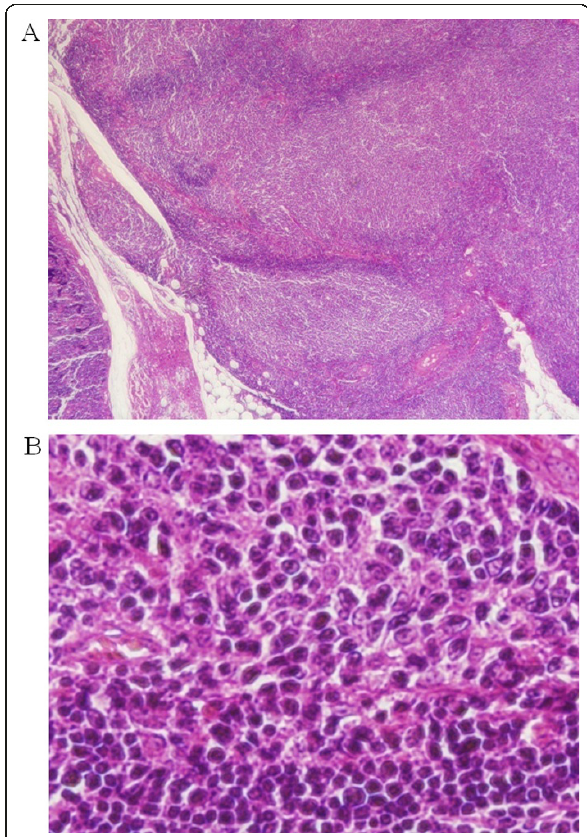
Figure 2 Light microscopic examination of recurrent tumor . Low-power magnification (×50) show that recurrent tumor cells formed follicular colonization in the germinal centers throughout the tumor (A). High-power magnification (×630) show centrocyte- like cells and plasmacytoid differentiation in the recurrent MALT lymphoma. Plasmacytoid differentiation was more prevalent in the recurrent tumor than in the primary tumor